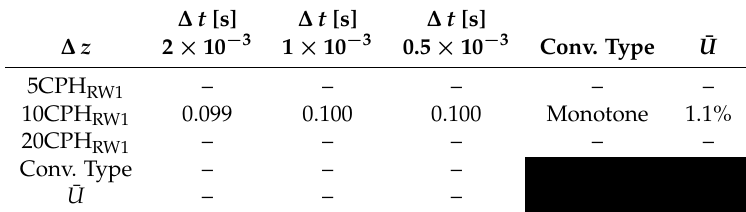
Table A4. Results of the temporal convergence study for RW3 ( T = 1.84 s, H = 0.094